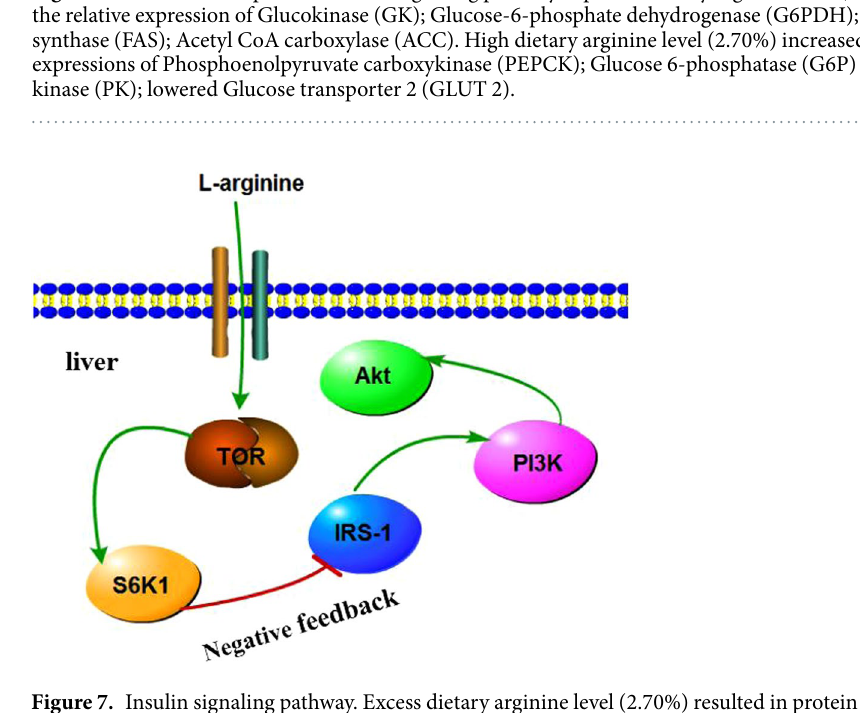
Figure 7. Insulin signaling pathway. Excess dietary arginine level (2.70%) resulted in protein S6 kinase 1 (S6K1) was over-expressed, which led to negative feedback in insulin resistance including inhibition of Insulin receptor substrate 1 (IRS-1); Phosphoinositide 3-kinase (PI3K) and Protein kinase B